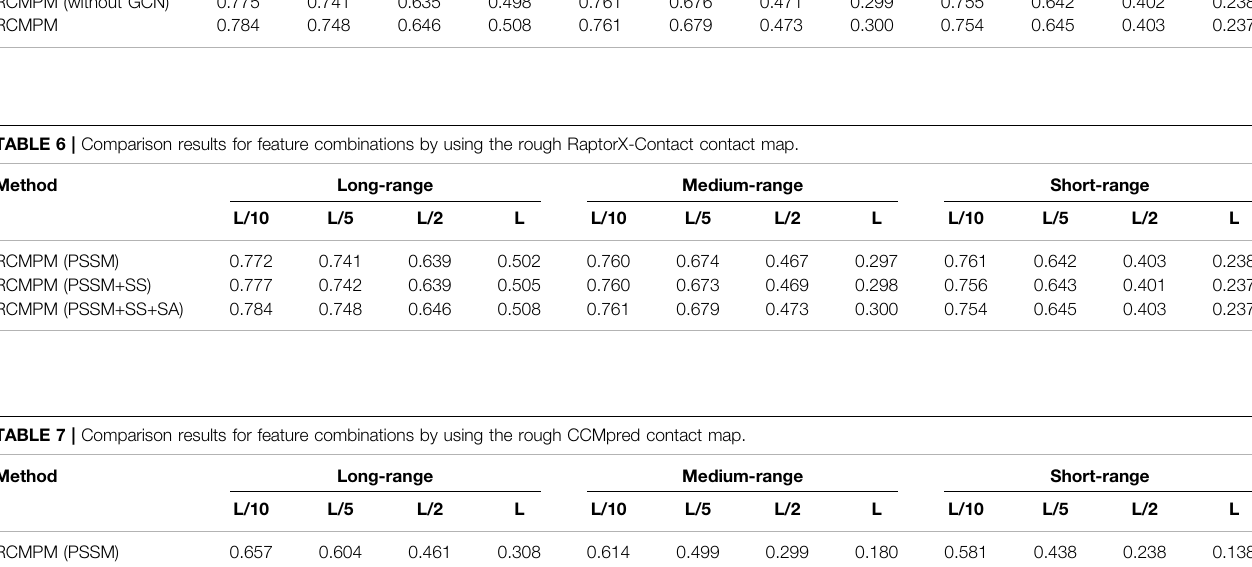
RCMPM (without GCN)